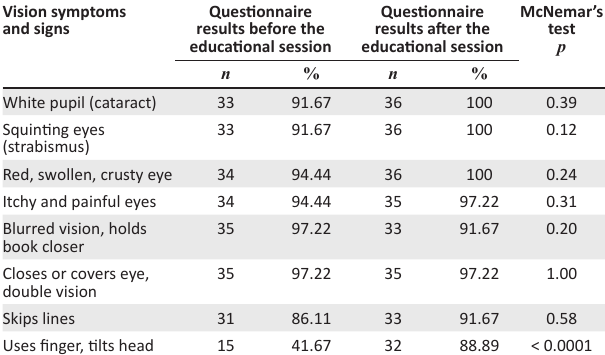
TABLE 5: Participants’ responses per different vision symptoms and signs. Vision symptoms and